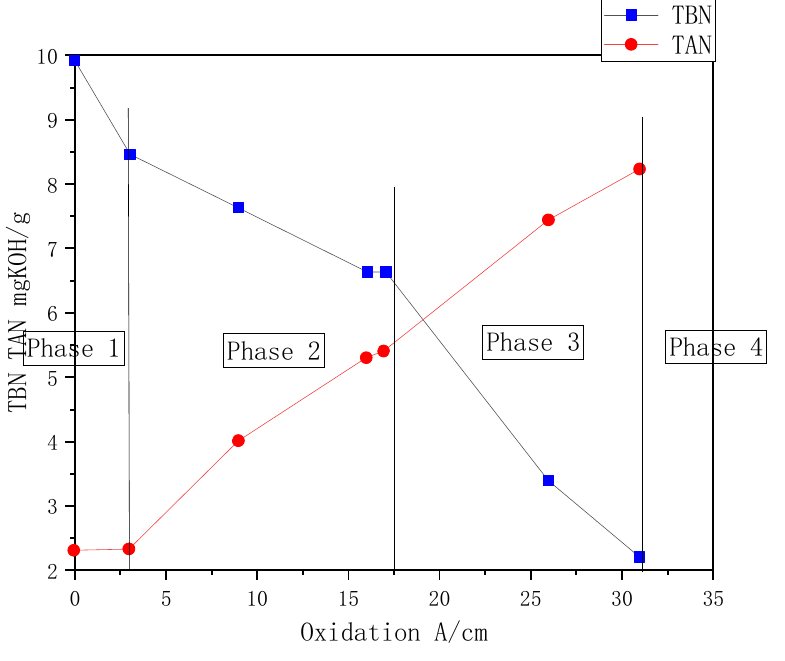
Figure 18. Engine oil (15W40) TBN and TAN were measured in a reference laboratory.